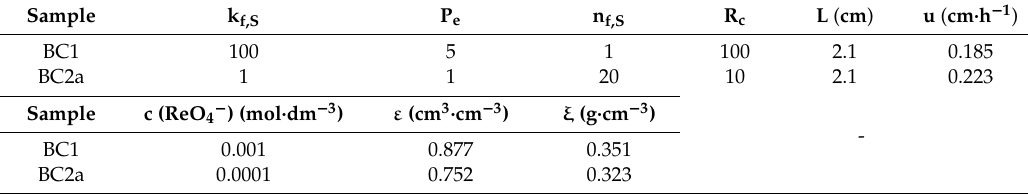
Figure 7. Freundlich isotherm of ( a ) BC1 and ( b ) BC2a. Semilogarithmic scale. Table 3. Estimated and inserted parameters as input data into code. These are the estimates necessary when using a nonlinear regression procedure.